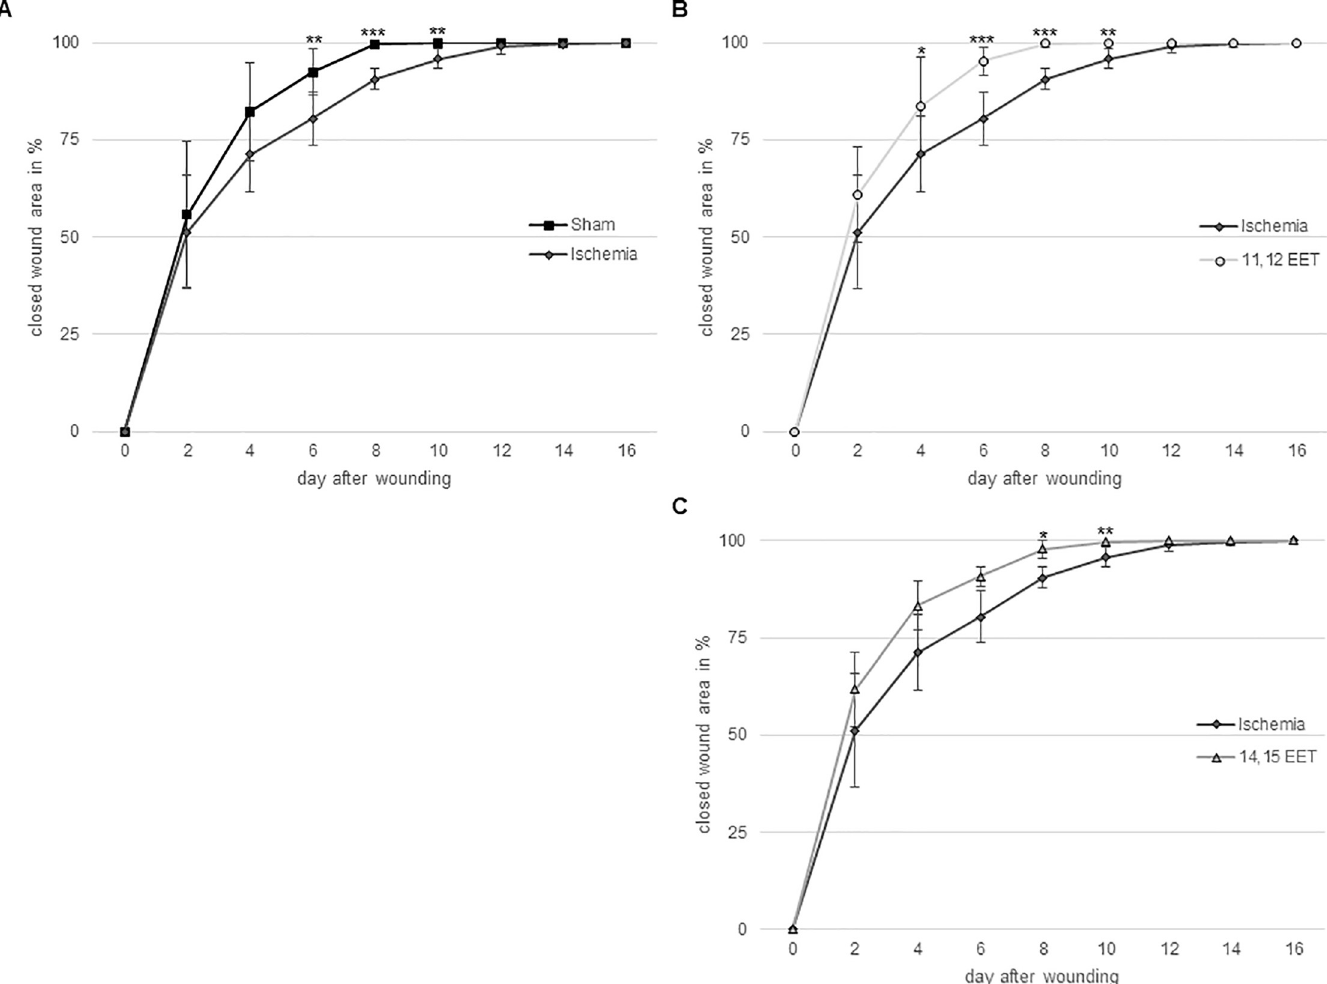
Fig 2. A Percentage of closed wound area from day 0–16 of ischemic and non-ischemic ears. B Percentage of closed wound area from day 0–16 of ischemic and 11,12 EET treated wounds. C Percentage of closed wound area from day 0–16 of ischemic and 14,15 EET treated wounds. (data is shown as mean ± SD; n = 10 ). � p < 0.05, �� p < 0.01, ��� p <